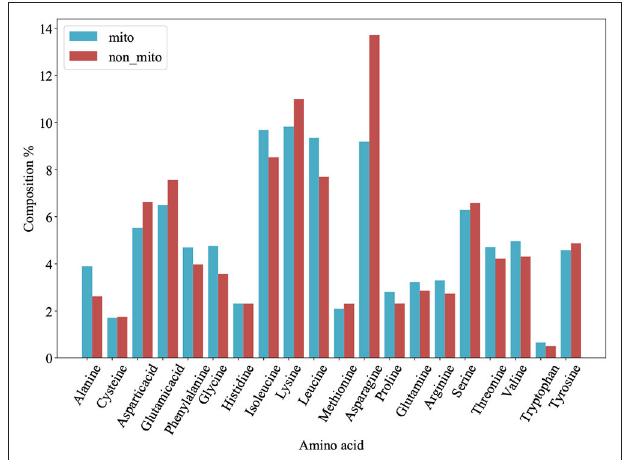
FIGURE 1 | Amino acid composition of 54 mitochondrial proteins (mito) and 221 non-mitochondrial proteins (non_mito). The abscissa represents the abbreviation of amino acid, and the ordinate represents the percentage content of amino acid.